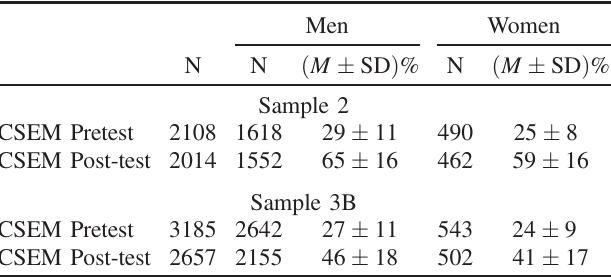
TABLE VI. CSEM pretest and post-test averages for samples 2 and 3B. Averages are reported as